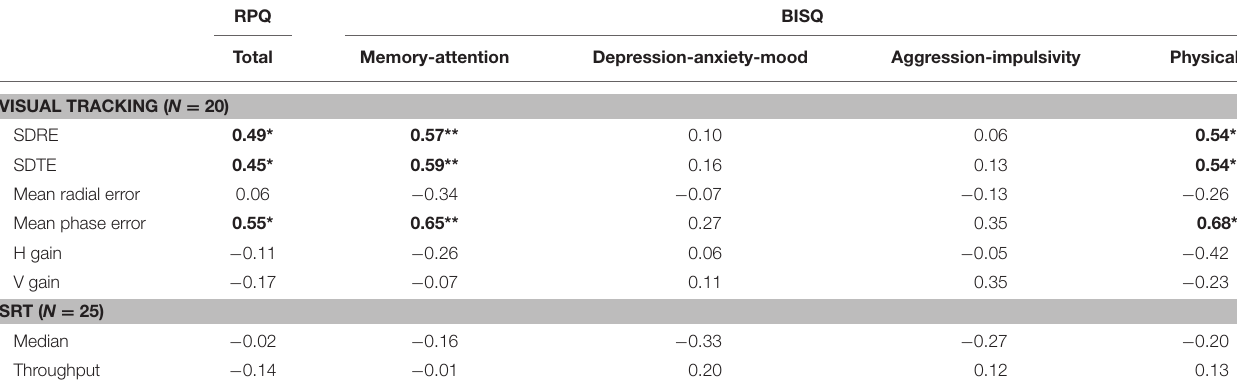
TABLE 2 | Pearson correlations between performance changes and symptom scores.